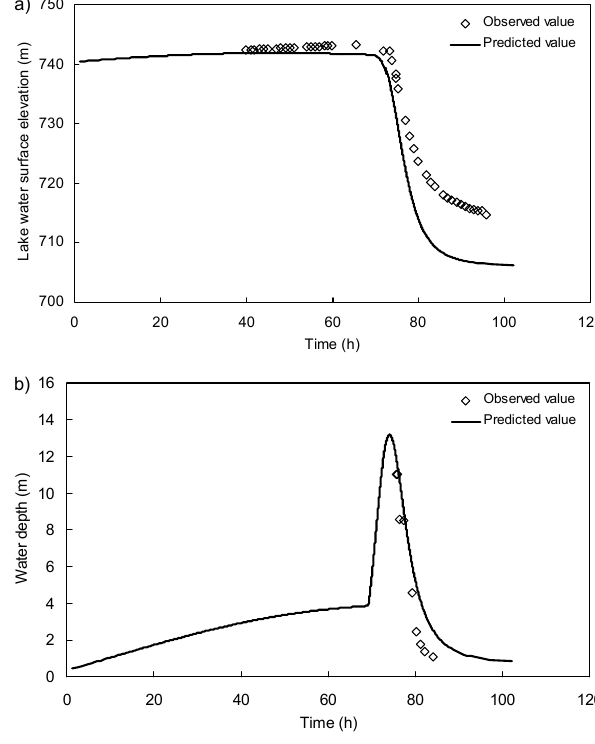
Fig. 11. Predicted and observed flow conditions during the erosion of the Tangjiashan landslide dam. ( a ) lake water level (observed data from Liu et al. 2009b); ( b ) water depth within the breach channel (observed data from Zhu et al. 2008).